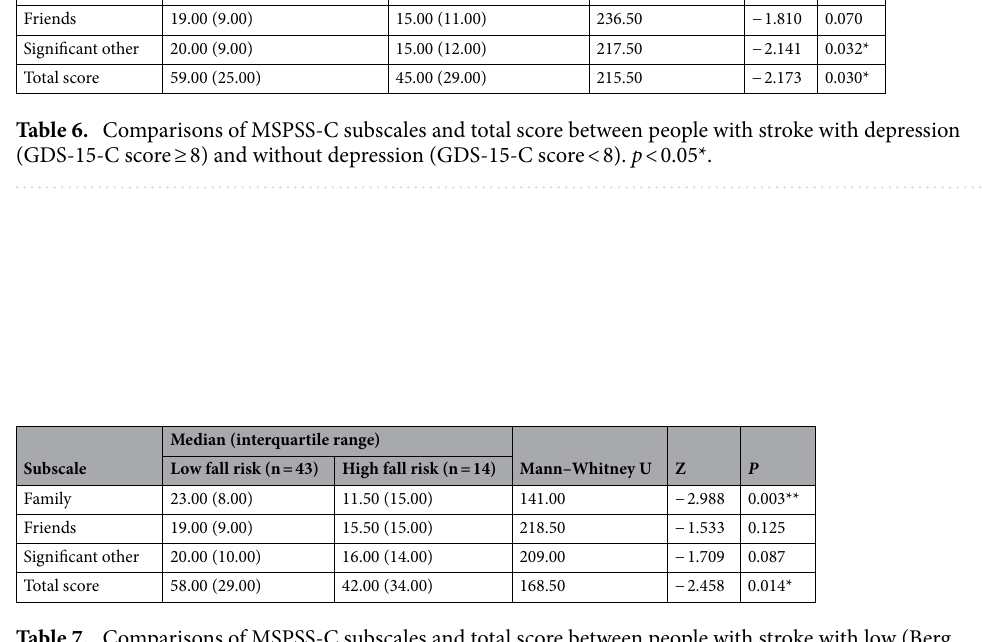
Table 7. Comparisons of MSPSS-C subscales and total score between people with stroke with low (Berg Balance Scale score ≥ 45) and high fall risk (Berg Balance Scale score < 45). p < 0.05*, p < 0.01**.